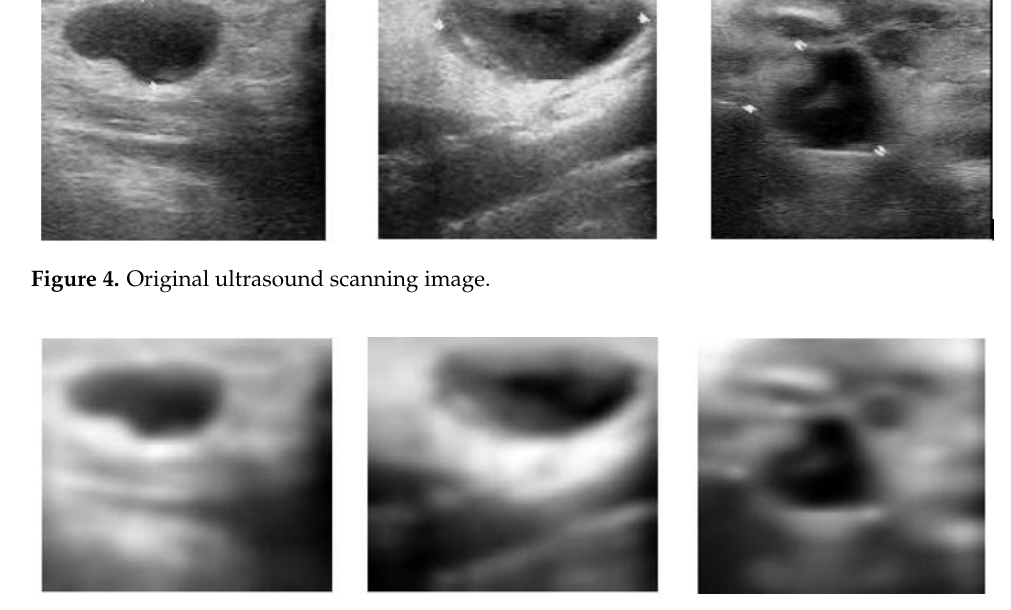
Figure 5. Filtered image.